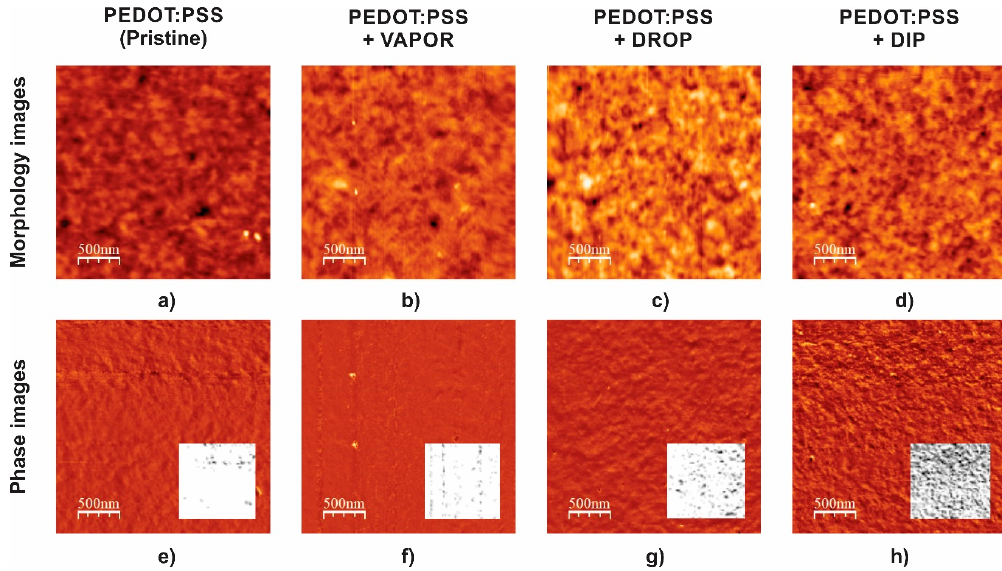
Figure 7. Atomic force microscopy (AFM) (morphology and phase) images of ( a ) and ( e ) pristine PEDOT:PSS film post-treated IPA PEDOT:PSS films using ( b ) and ( f ) VAPOR, ( c ) and ( g ) DROP, and ( d ) and ( h ) DIP techniques; high-contrast phase images (inset images) Table 2. Electrical and morphological characteristics of pristine PEDOT:PSS film and post-treated PEDOT:PSS films.